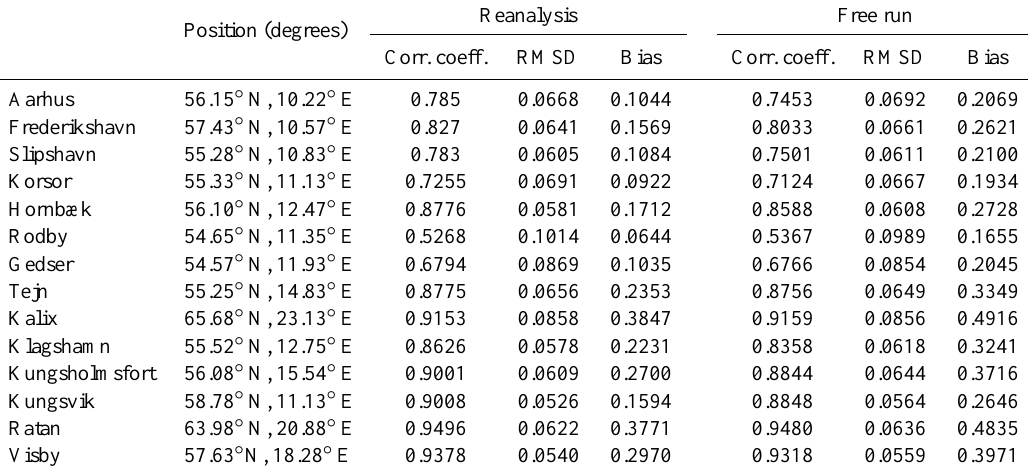
Table 1. The correlation coefficients, bias (in m) and RMSD (in m) of the model compared to observed tide gauge data in 14 stations. The RMSD is calculated with the residual of time series after the mean is subtracted. Position (degrees) Corr. coeff. Corr.